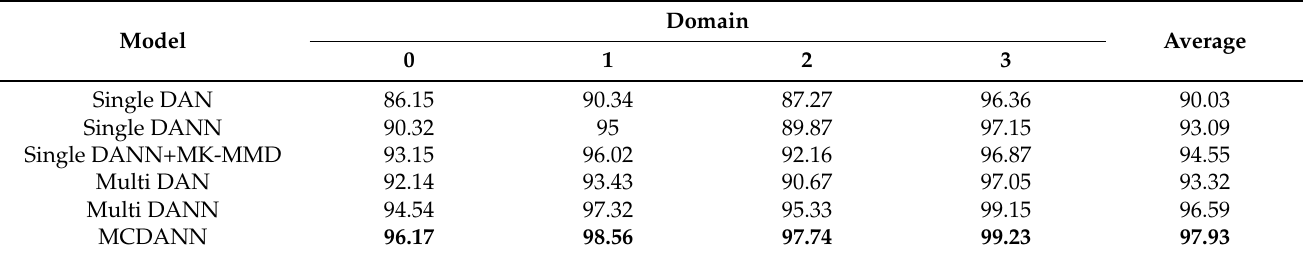
Table 3. CWRU classification accuracy of different models on unknown working condition without labels. (SNR = − 4)